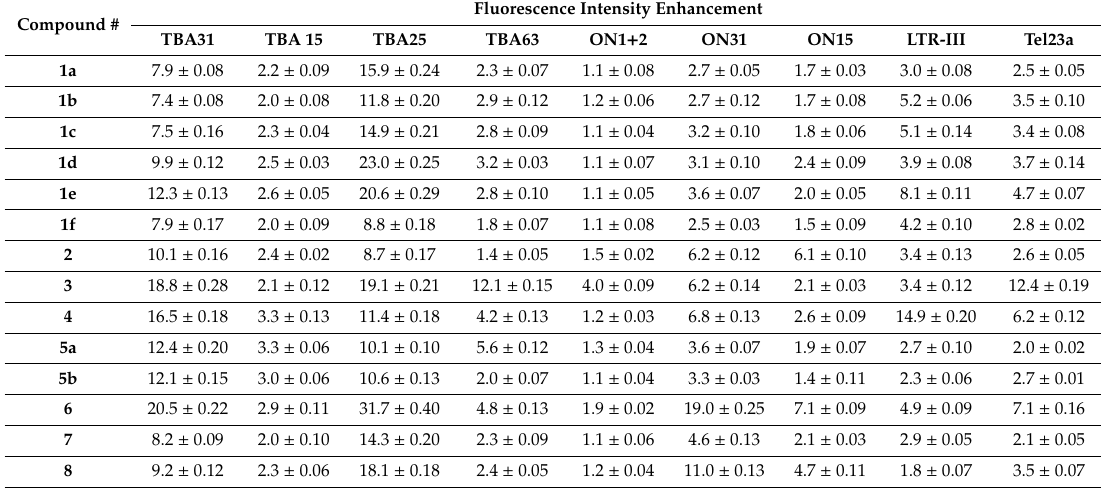
Table 2. Fluorescence intensity enhancement of selected GFP chromophore analogues upon binding to